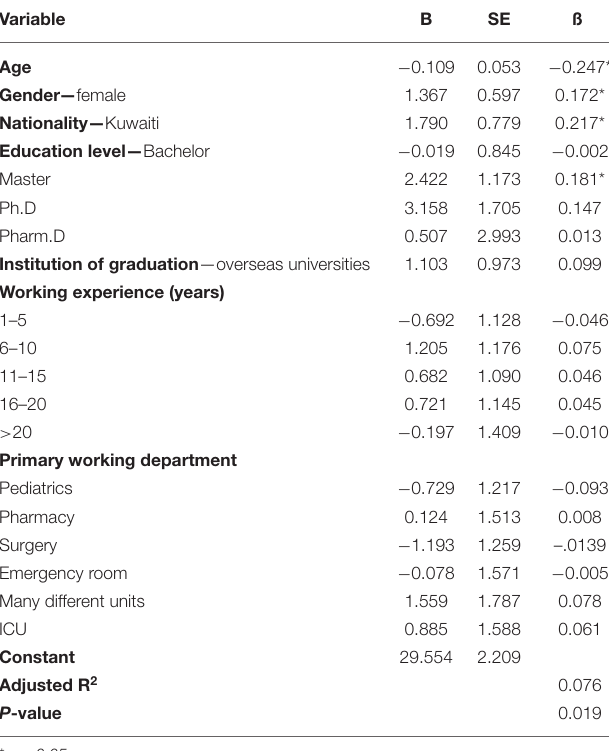
TABLE 11 | Multiple-linear regression predicting attitudes of HCPs toward MEs reporting.